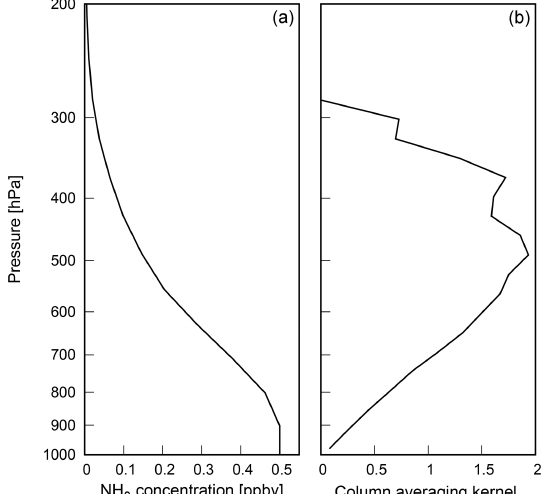
Figure 2. Ammonia concentration of the AFGL profiles (a) and the column averaging kernel for the a priori ammonia profile using mid- latitude summer atmosphere (b) .